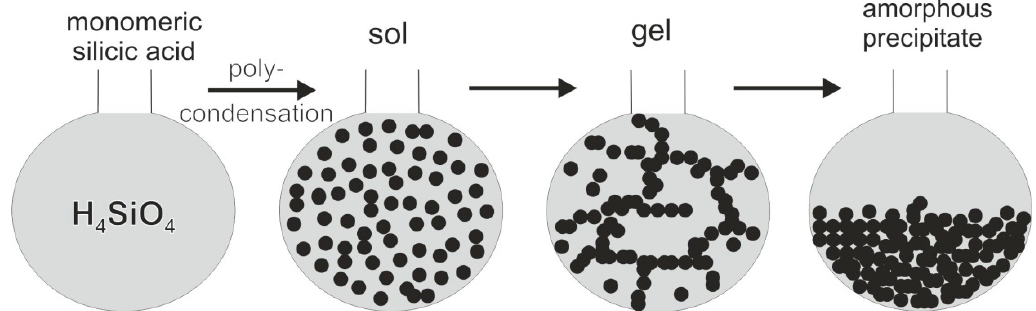
Figure 28. Schematic development of silica from monomeric silicic acid to an amorphous precipitate during the transport and accumulation processes.